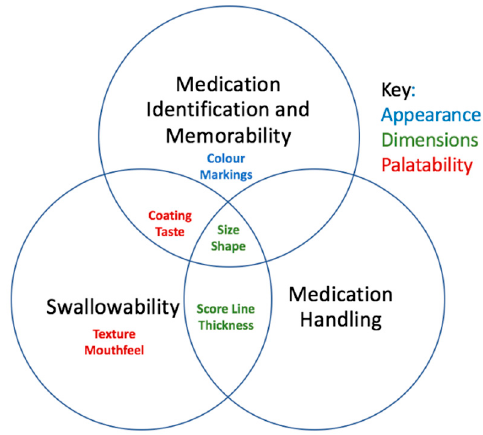
Figure 2. The relationship between key characteristics and each stage of the medication taking process.